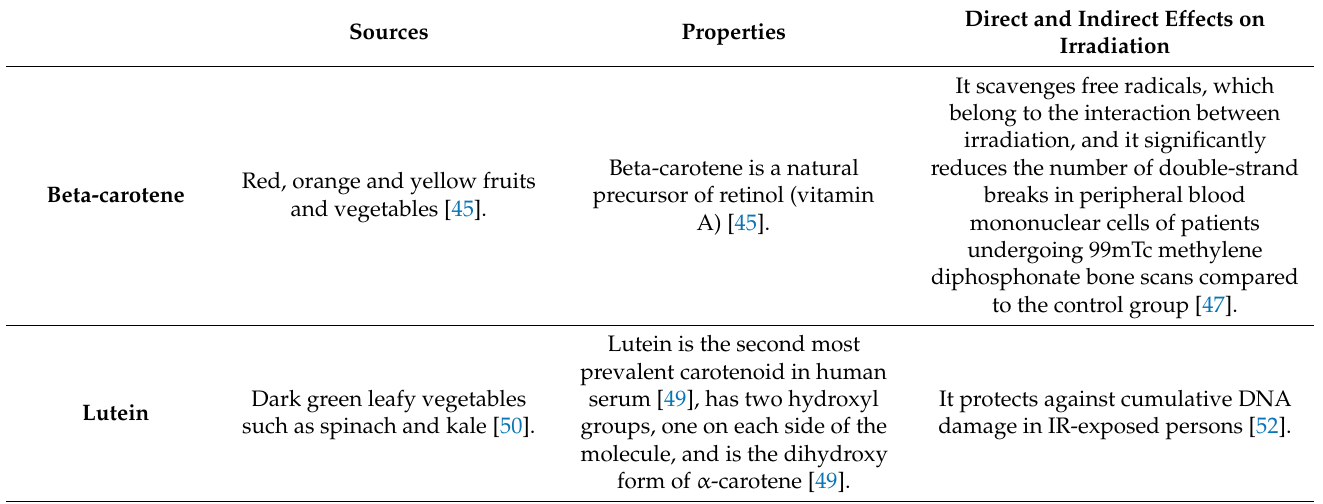
Table 1. Nutraceutical properties of natural compounds and their protective effects under